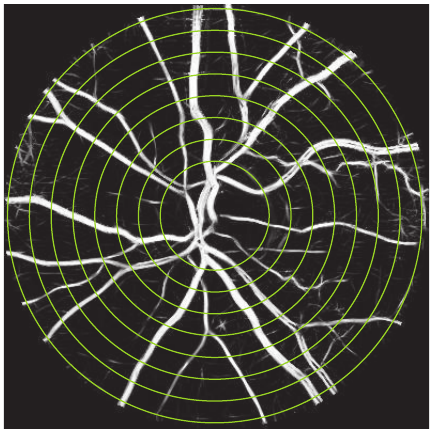
Figure 2: Demonstration of circular scanning paths using an enhanced retinal image. The scanning paths have been demon- strated with several pixels intervals for better visualization